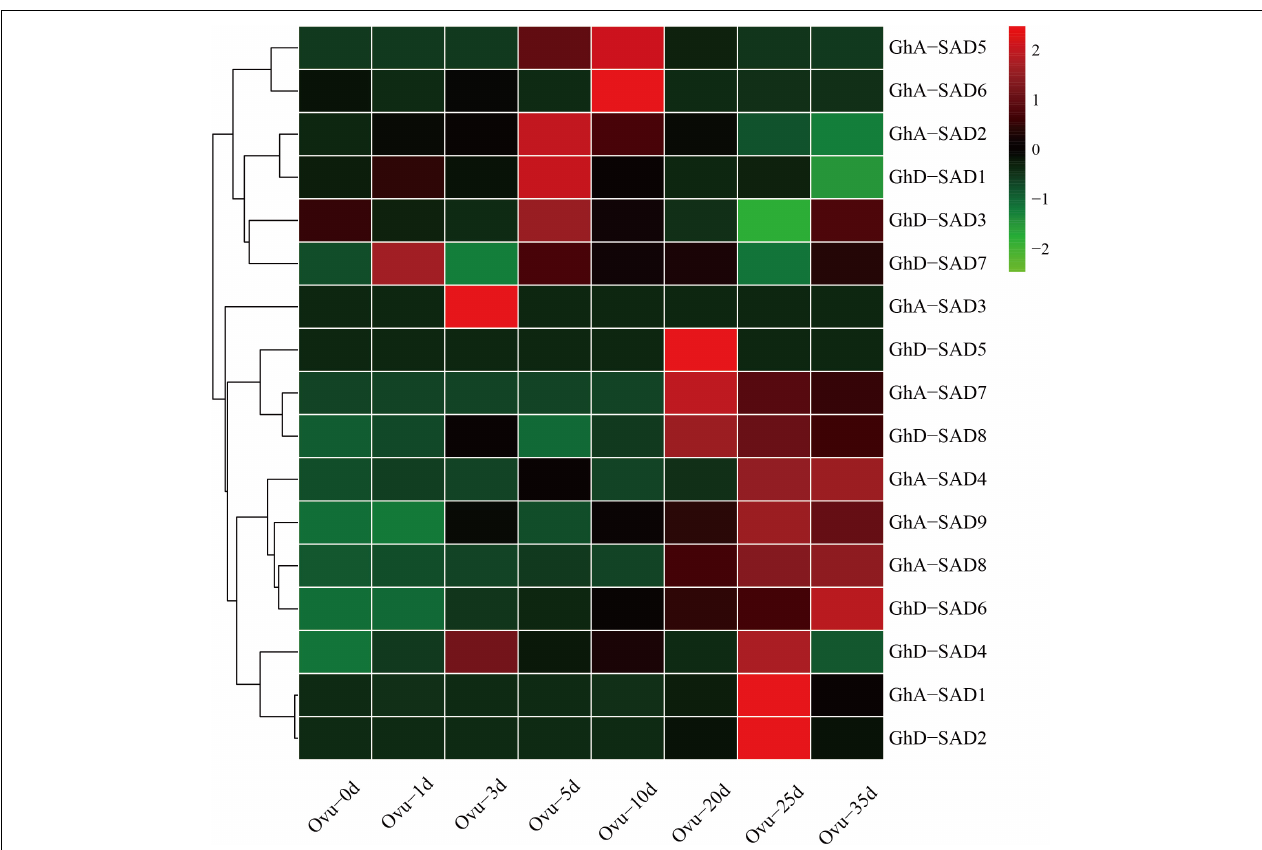
FIGURE 3 | Transcriptional expression patterns of 16 GhSAD family members during developing cotton ovule. The RNA-seq data used here were derived from NCBI database. The developing ovule stages were listed as 0d, 1d, 3d, 5d, 10d, 20d, 25d, and 35d after flowering (DAF) in developing cotton ovules.